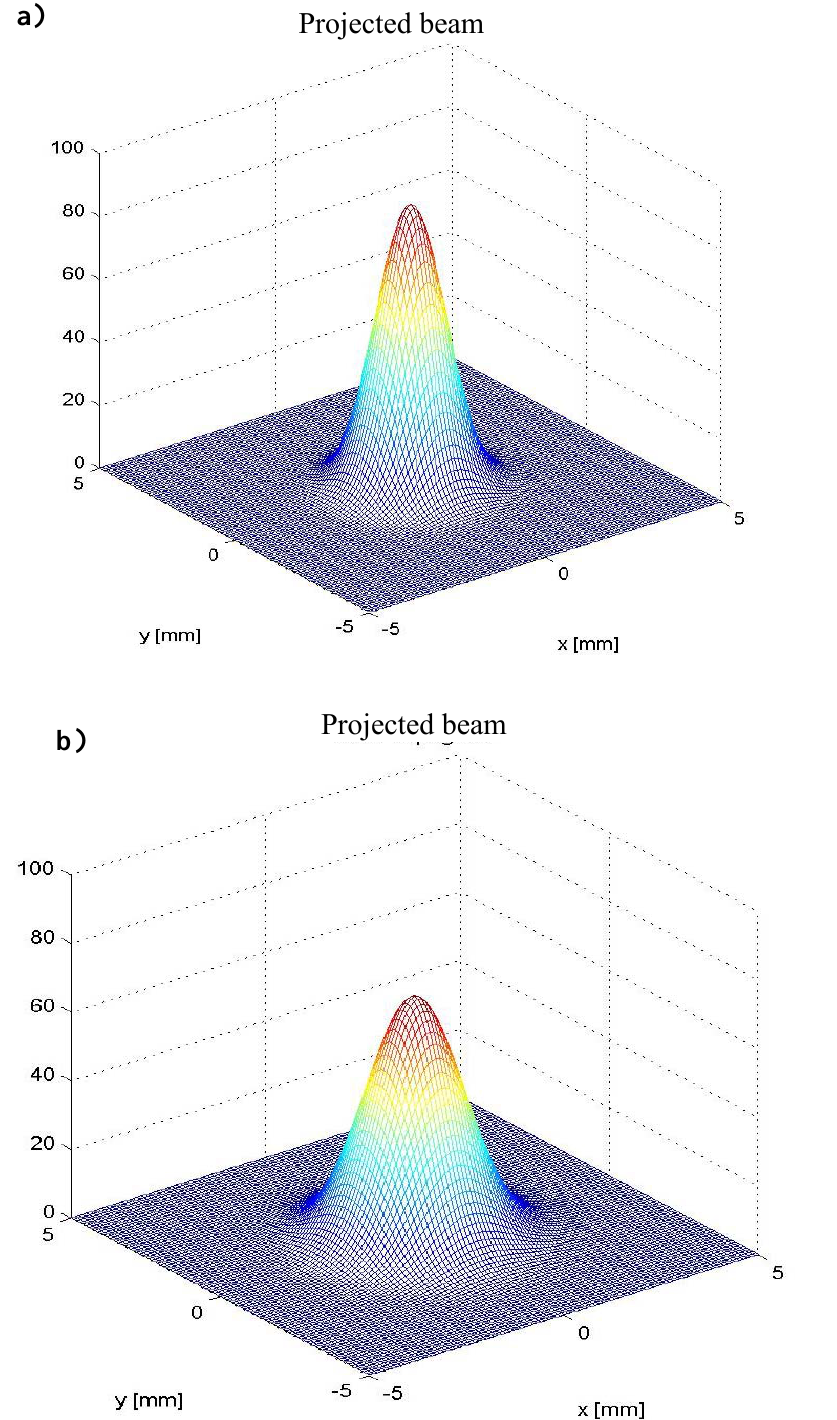
Figure 8. Signal energy attenuation and distribution in projected spot: a) striking distance 2.5 m. b) striking distance 5.0